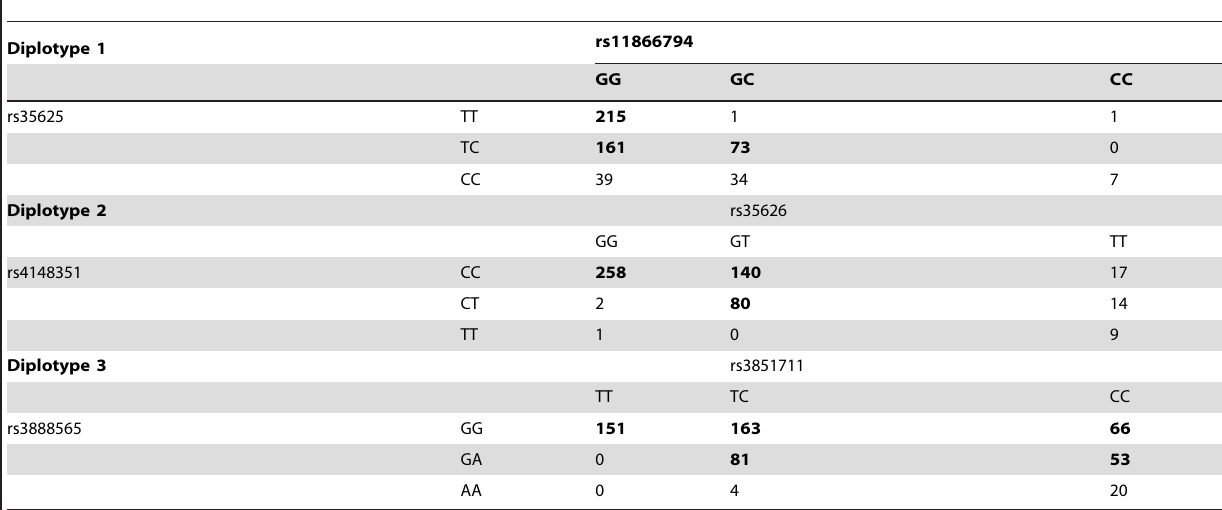
Table 3. Distribution of ABCC1 diplotypes predicted by HaploView v4.2.